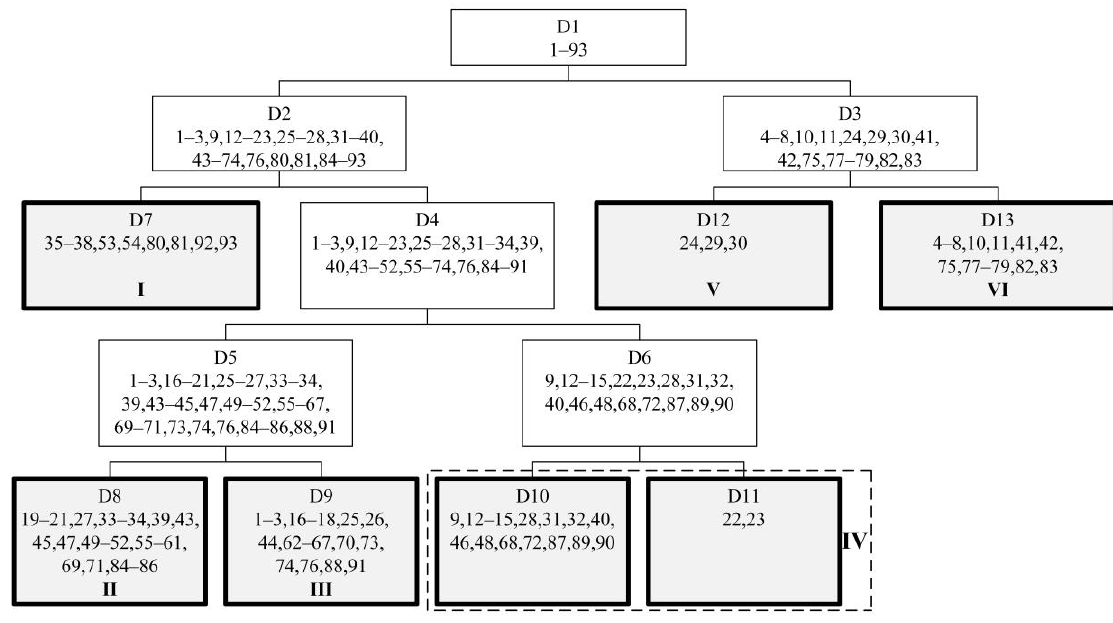
Figure 4. TWINSPAN dendrogram. Table 3. Ecological characteristics of TWINSPAN